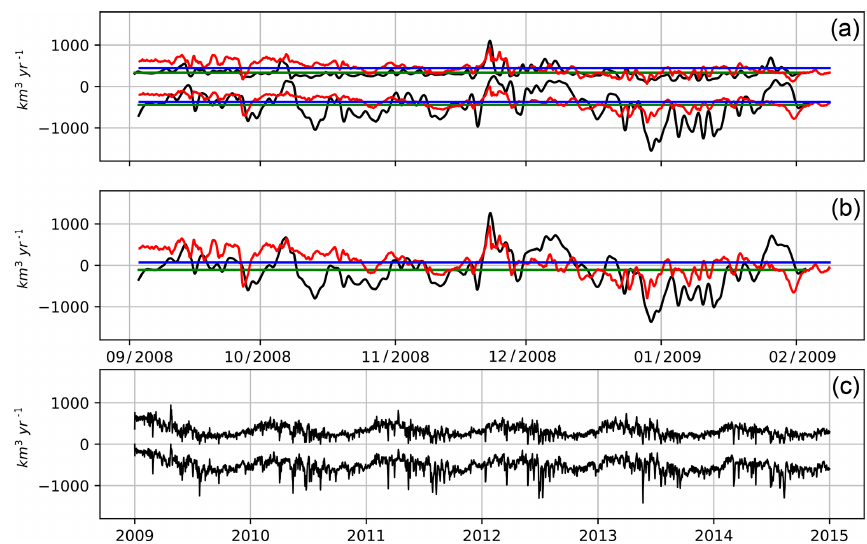
Figure 6. Time series of water transport at Bosphorus Strait. (a) Upper and lower fluxes from the model (red line) and from observations (black line) compared for the August 2008 to January 2009 period. (b) Net water transport from model (red line) and observation (black line). (c) Upper and lower layer fluxes from the model for the entire model run period. Table 2. Water transport (km 3 yr − 1 ) components at the two ends and mid-strait sections of the Bosphorus, based on analyses (1) and observations (2, 3, 4) compared with model